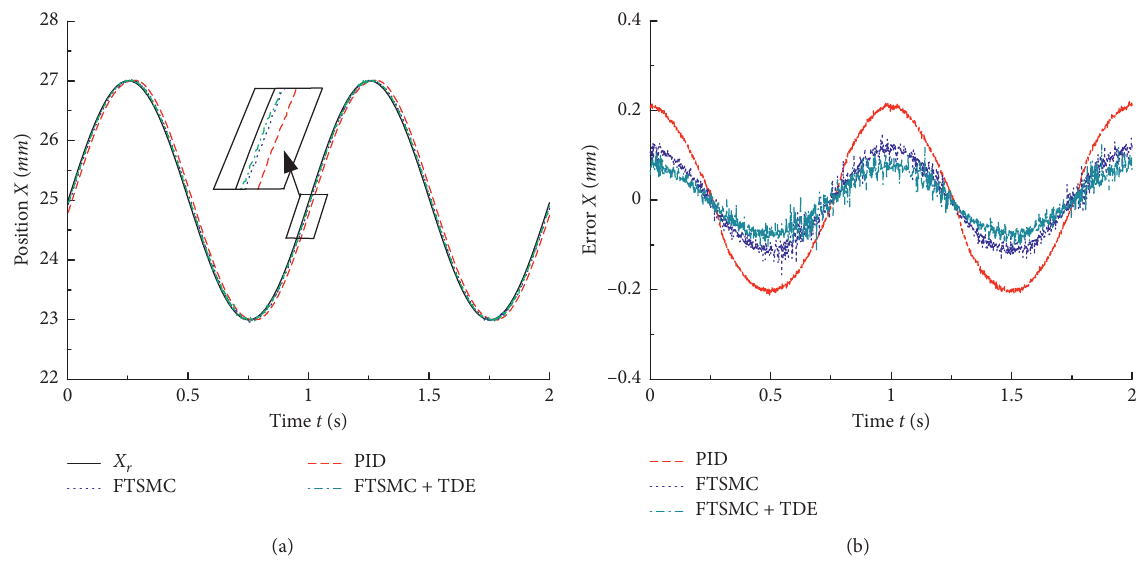
Figure 10: Working condition ③ in Table 4. (a) Position of 2 mm amplitude and 1Hz frequency. (b) Position error of 2mm amplitude and 1Hz frequency.